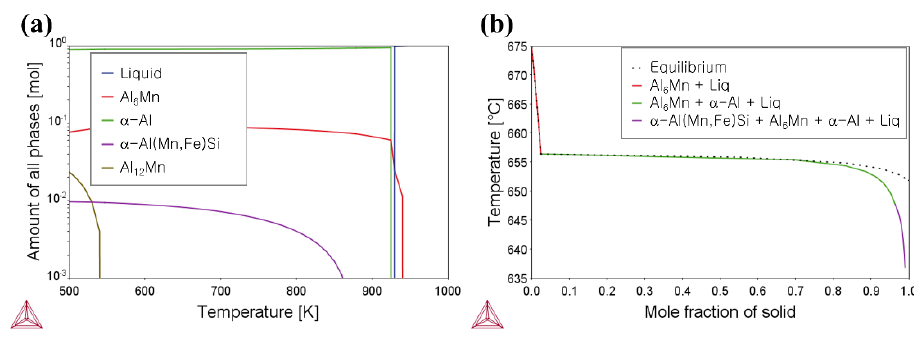
Figure 2. ( a ) Equilibrium phase fraction change with temperature ( b ) Scheil–Gulliver solidification calculation.